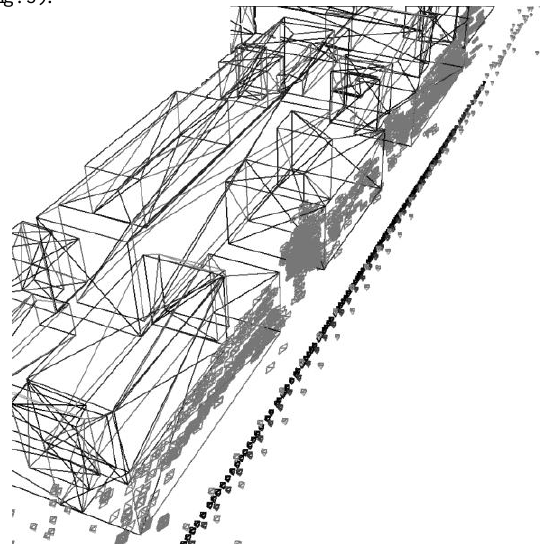
Figure 4. Grid model of the building with point cloud (light grey) and camera path: light grey: GPS path, dark grey transformed estimated camera positions